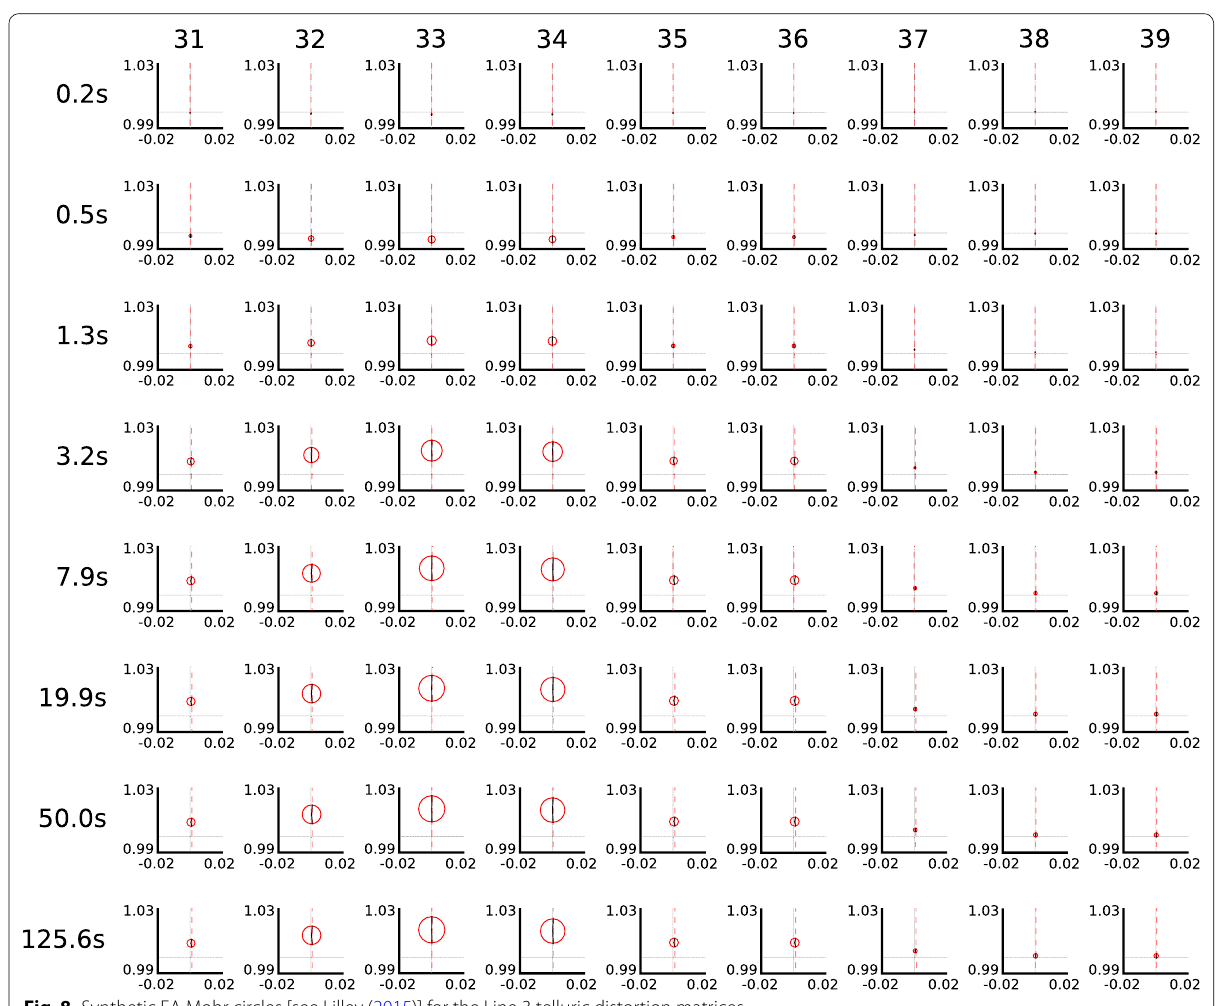
Fig. 8 Synthetic EA Mohr circles [see Lilley (2015)] for the Line 3 telluric distortion